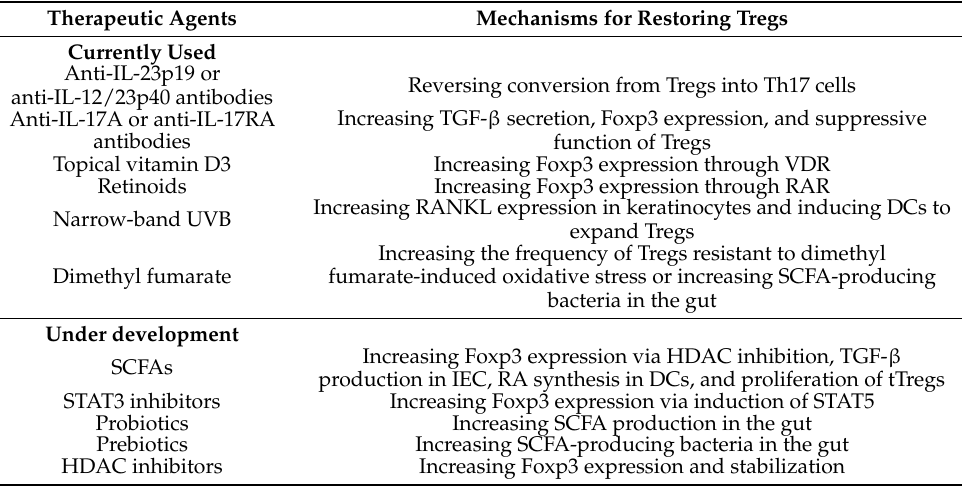
Table 1. Therapeutic Agents Restoring Defected Regulatory T Cells (Tregs) in